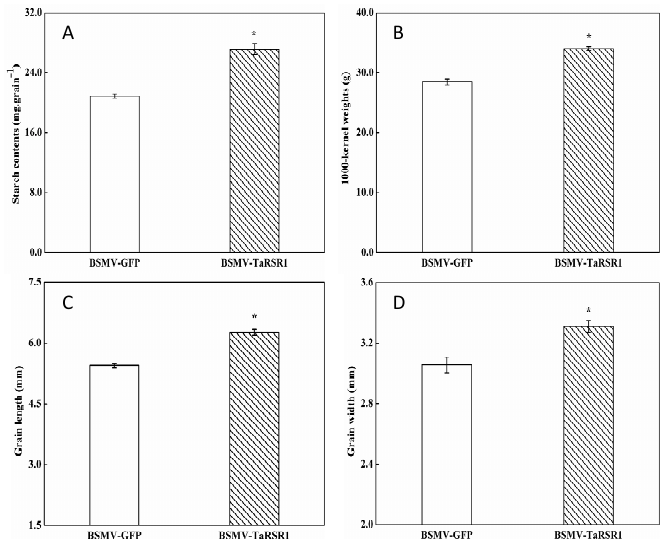
Figure 2. Matured grain starch contents ( A ); 1000-kernel weights ( B ); length ( C ); and width ( D ) of BSMV-TaRSR1-infected and BSMV-GFP-infected wheat spikes. Each value is the mean ± standard deviation of three independent biological replicates. Asterisks indicate significant differences ( p < 0.05).